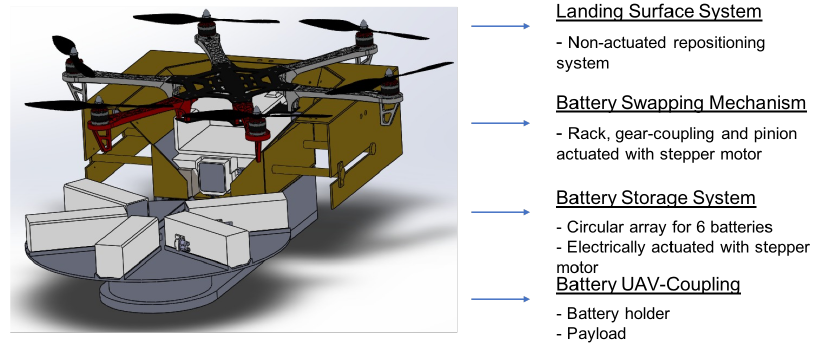
Figure 1. Robotic ground-station